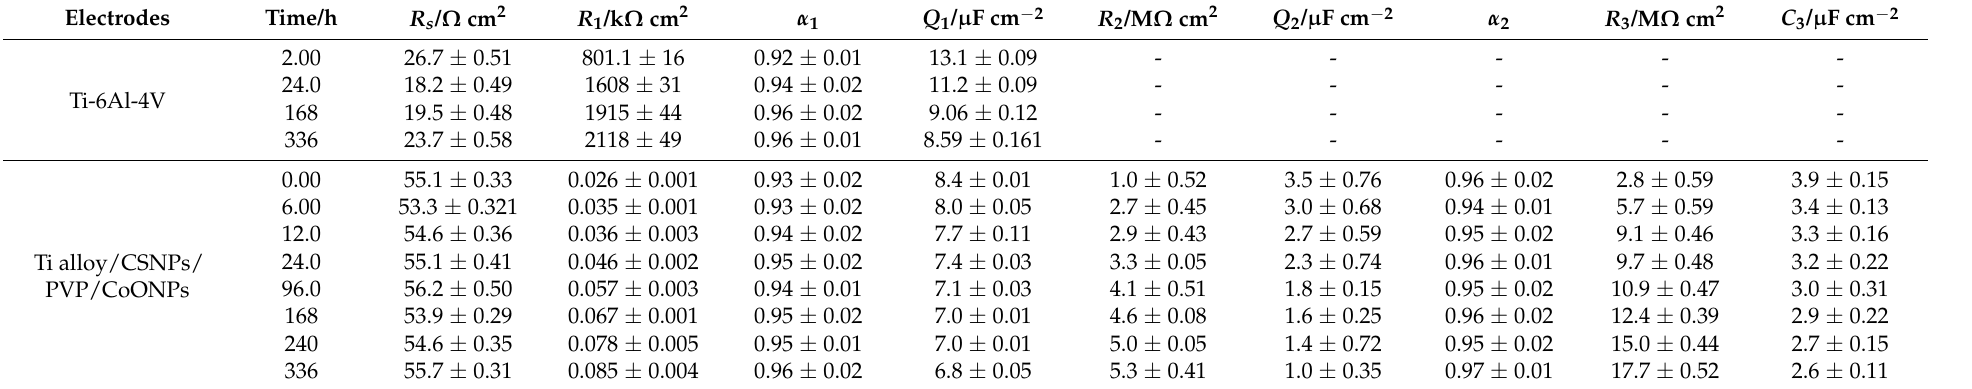
Table 1. The impedance parameters of bare and coated Ti alloy in artificial saliva solution of pH 7.4 at 37 ◦